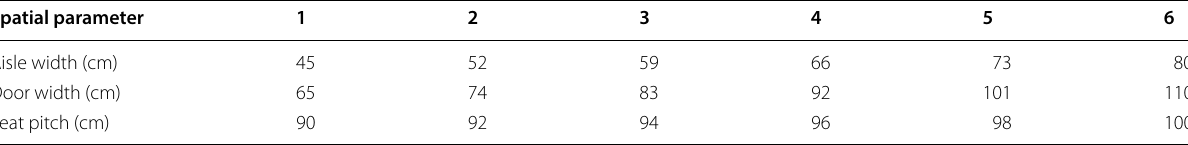
Table 5 Six levels of the three spatial parameters Spatial parameter